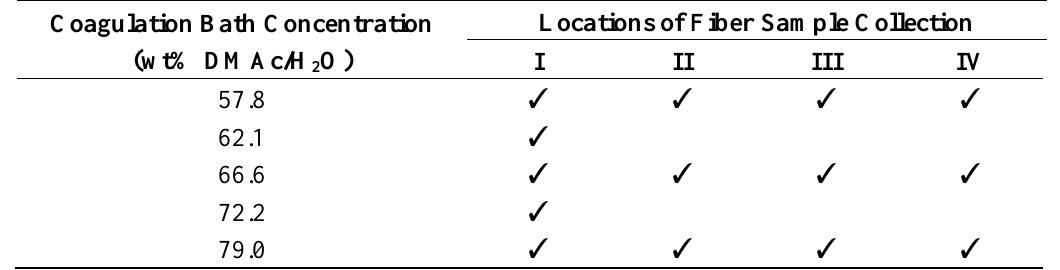
Figure 3. Schematic of the solution spinning line at the UKY CAER, labeled with sampling points (I–IV). ( I ) After coagulation; ( II ) after washing; ( III ) after hot stretching; ( IV ) on the traversing takeup. Table 1. Locations of fiber sample collections along the spinline at various coagulation bath